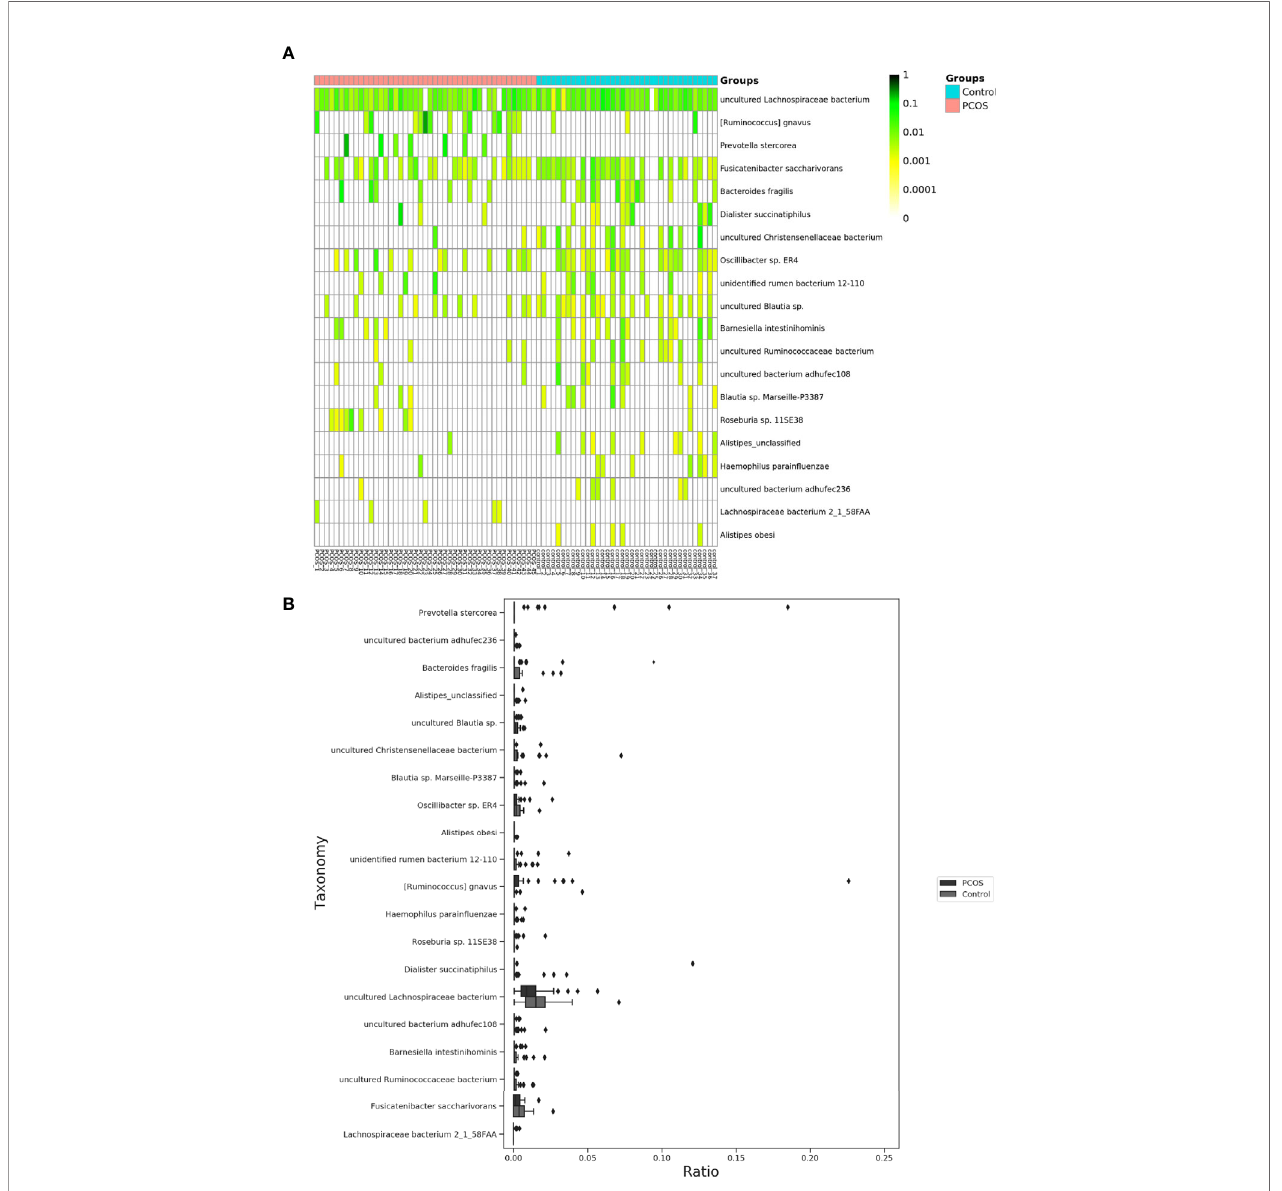
FIGURE 4 | Distinct species of microbiota between PCOS and control groups. (A) , Heatmap of species that had different abundances. A color gradient was used to show abundance (white=not detected). The number of samples is shown on the bottom, and the name of species is shown on the right. (B) , Box plot of species with different abundances. The species listed on (A, B) were those that showed a signi fi cant difference in abundance in LEfSe analysis. LEfSe, linear discriminant analysis effect size; PCOS, polycystic ovary